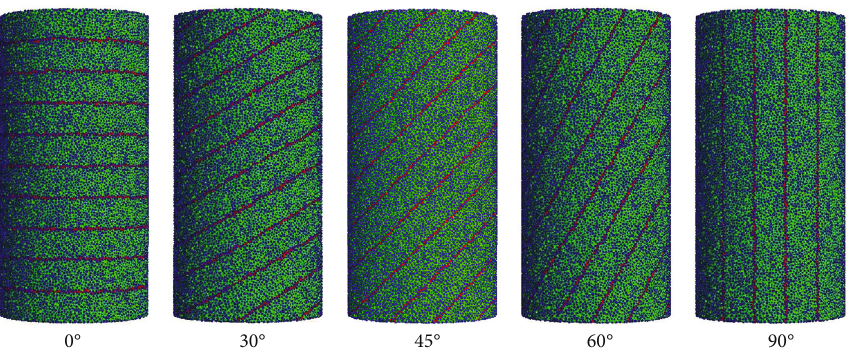
Figure 3: Uniaxial compression physical model of layered slate under di ff erent bedding inclination